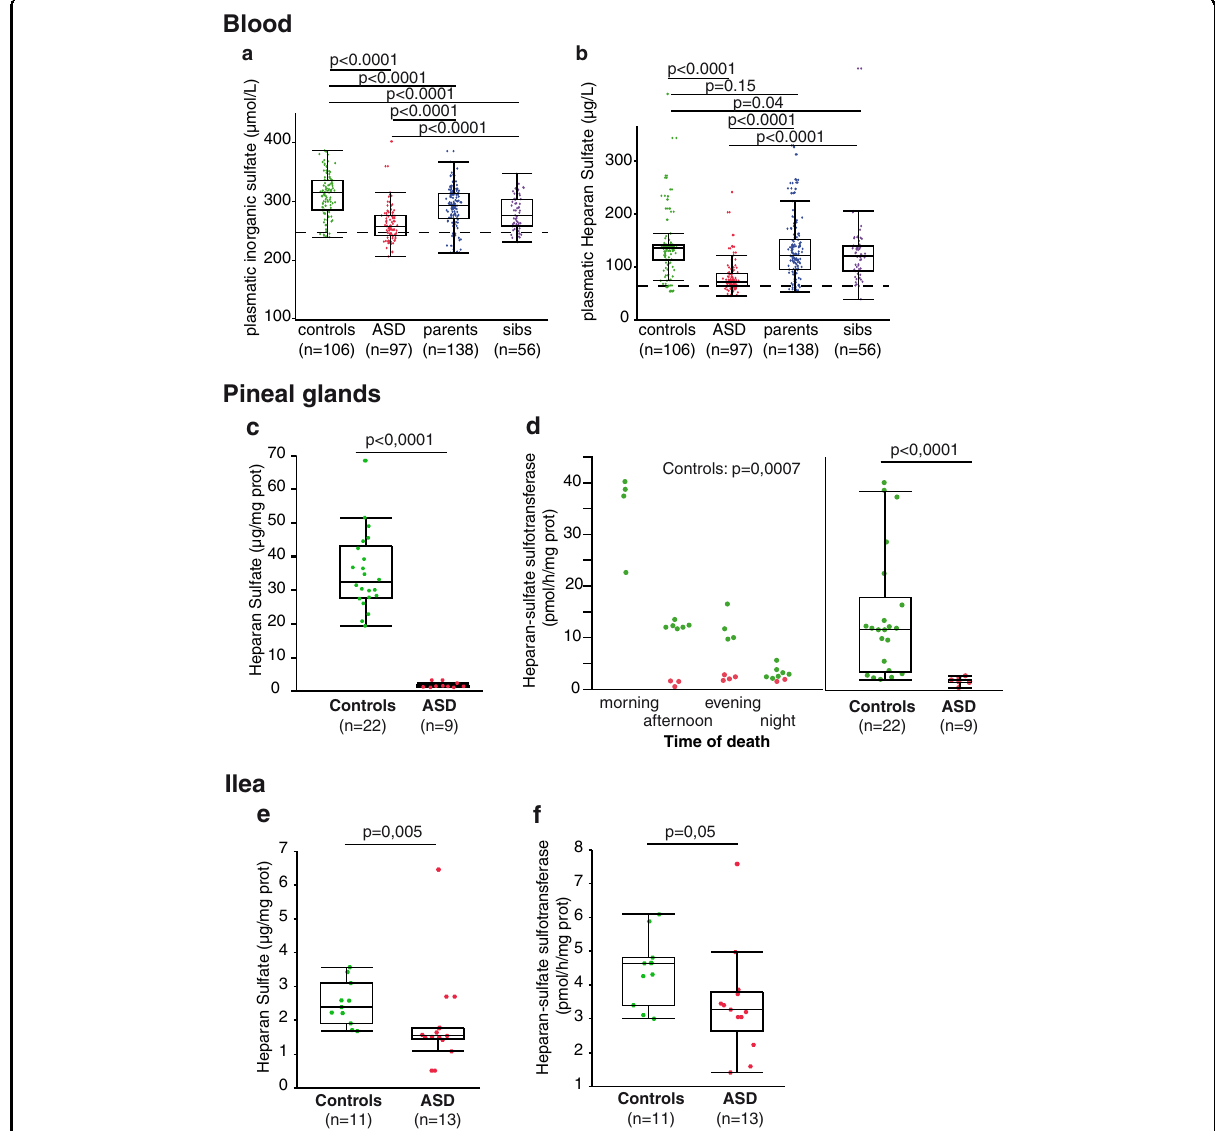
Fig. 4 Sulfation metabolism in ASD. a Plasma inorganic sulfate concentrations. b Plasma HS concentrations. c Pineal HS contents. d Pineal heparan sulfate sulfotransferase activities, strati fi ed by time of death (left panel) and pooled for comparison (right panel). e Ileal heparan sulfate contents. f Ileal heparan sulfate sulfotransferase activities. Boxes indicate medians and quartiles. Groups were compared using the Wilcoxon two-sample